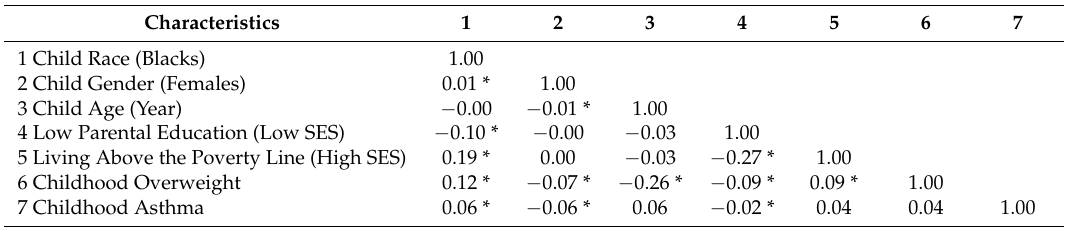
Table 2. Correlation matrix in the pooled sample ( n = 86,537).